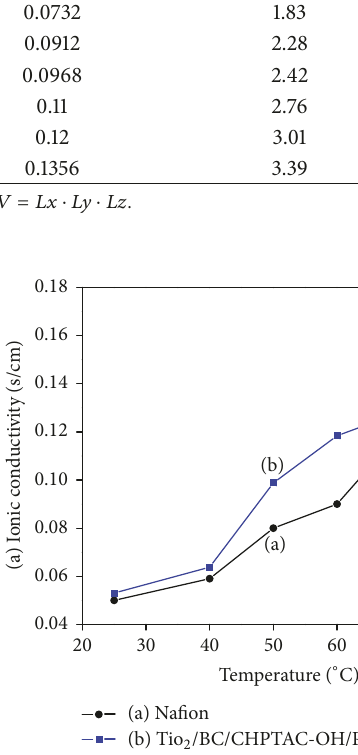
Figure 6: The ionic conductivity of the composite films at different